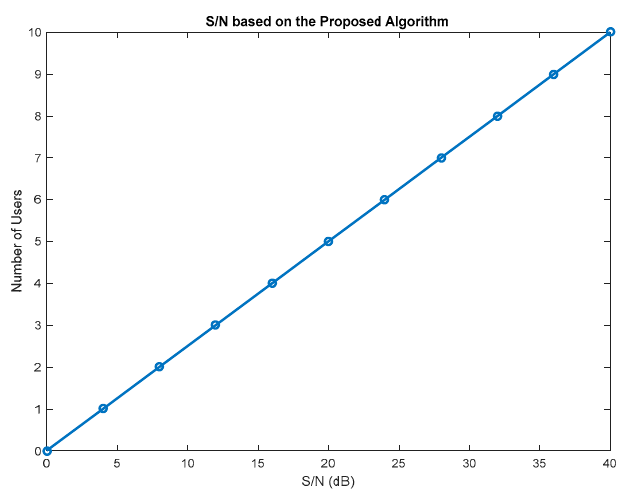
Figure 5. Signal to Noise (S/N) vs the number of users.